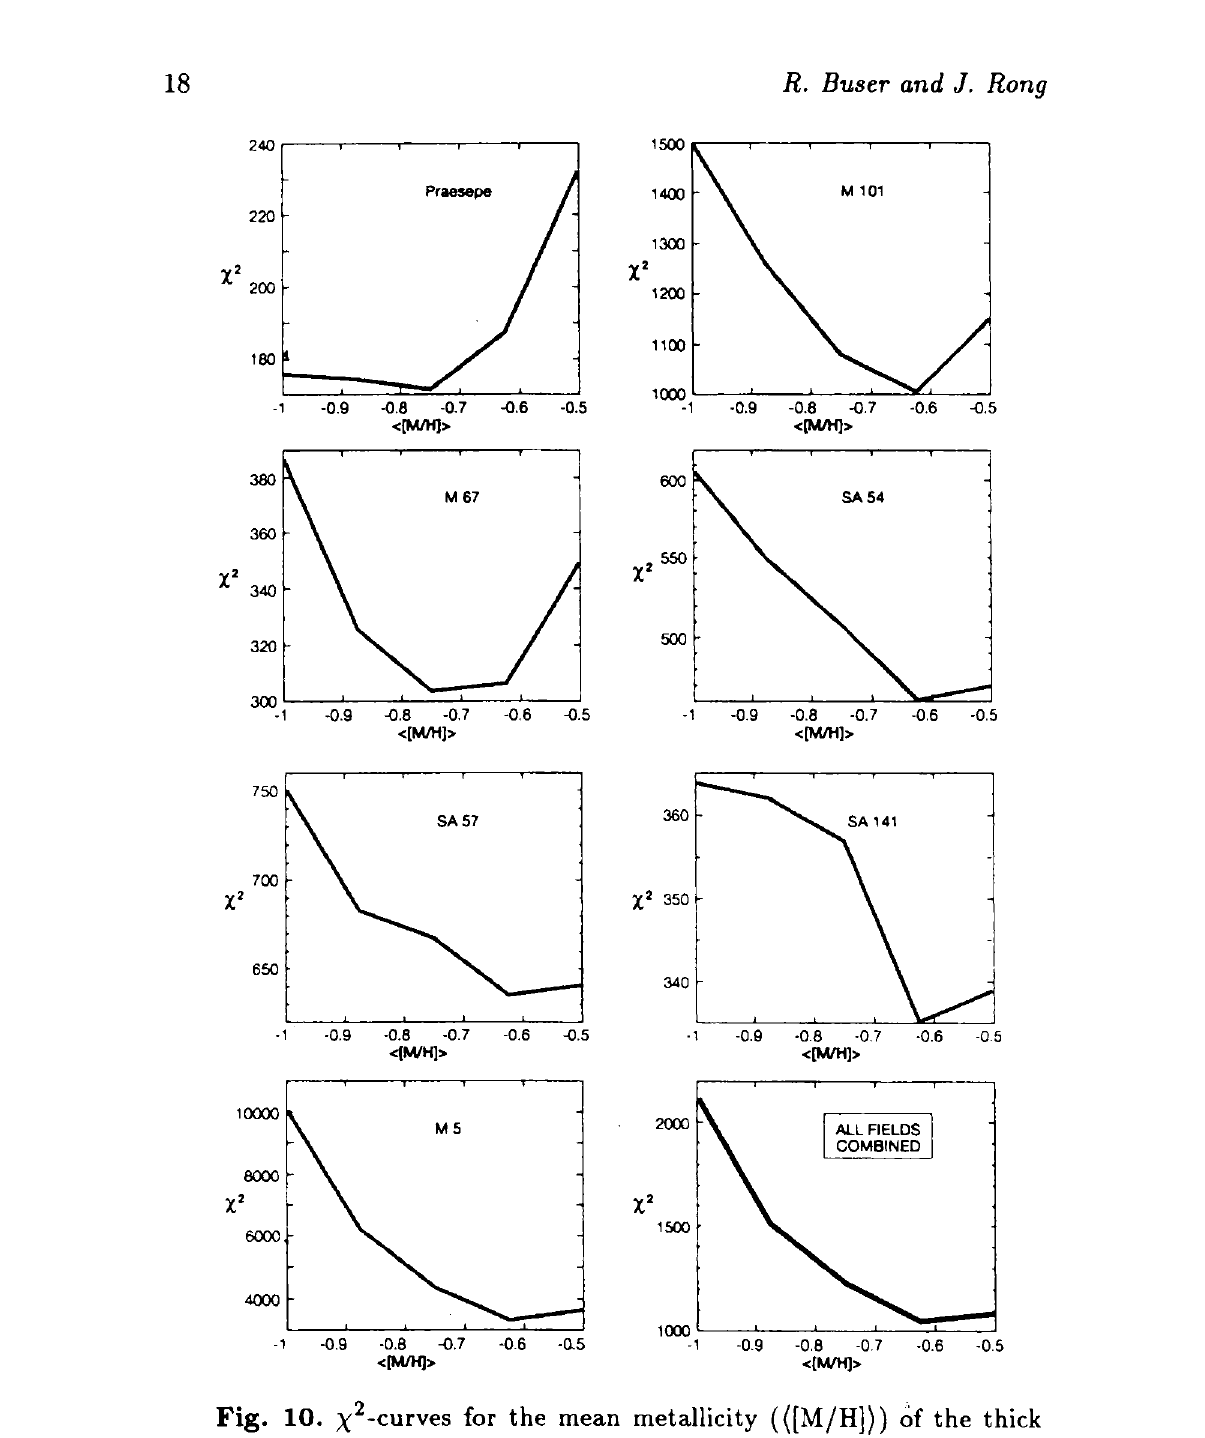
disk component calculated from the observed ( G, G-R, U-G)- data in each of the seven fields, plus averaged result for combined survey data (lower